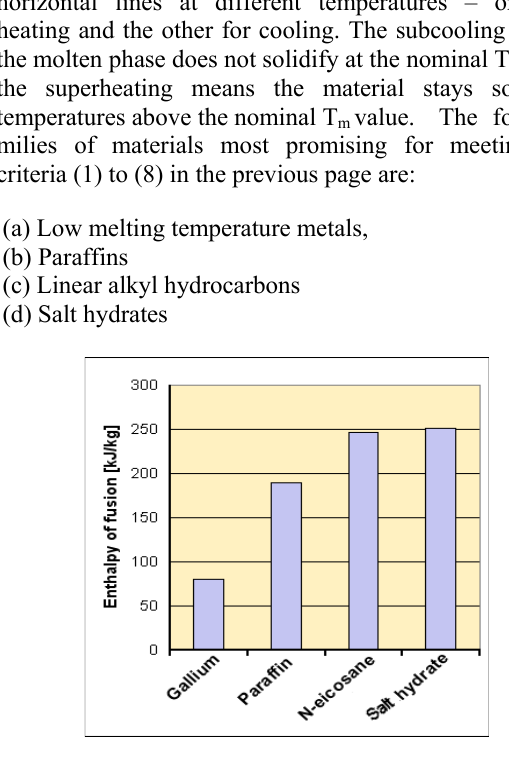
Fig. 6. Selected examples of heat stored per unit of mass – one from each of the four discussed latent-heat storage material families: low-melting-point metals, paraffins, alkyls, and salt hydrates. Of course, high value of the fusion heat e L shown here is, together with the temperature presented in Fig. 5, the prime factor in choice of the used material. There are, however, other properties that may be of importance in particular